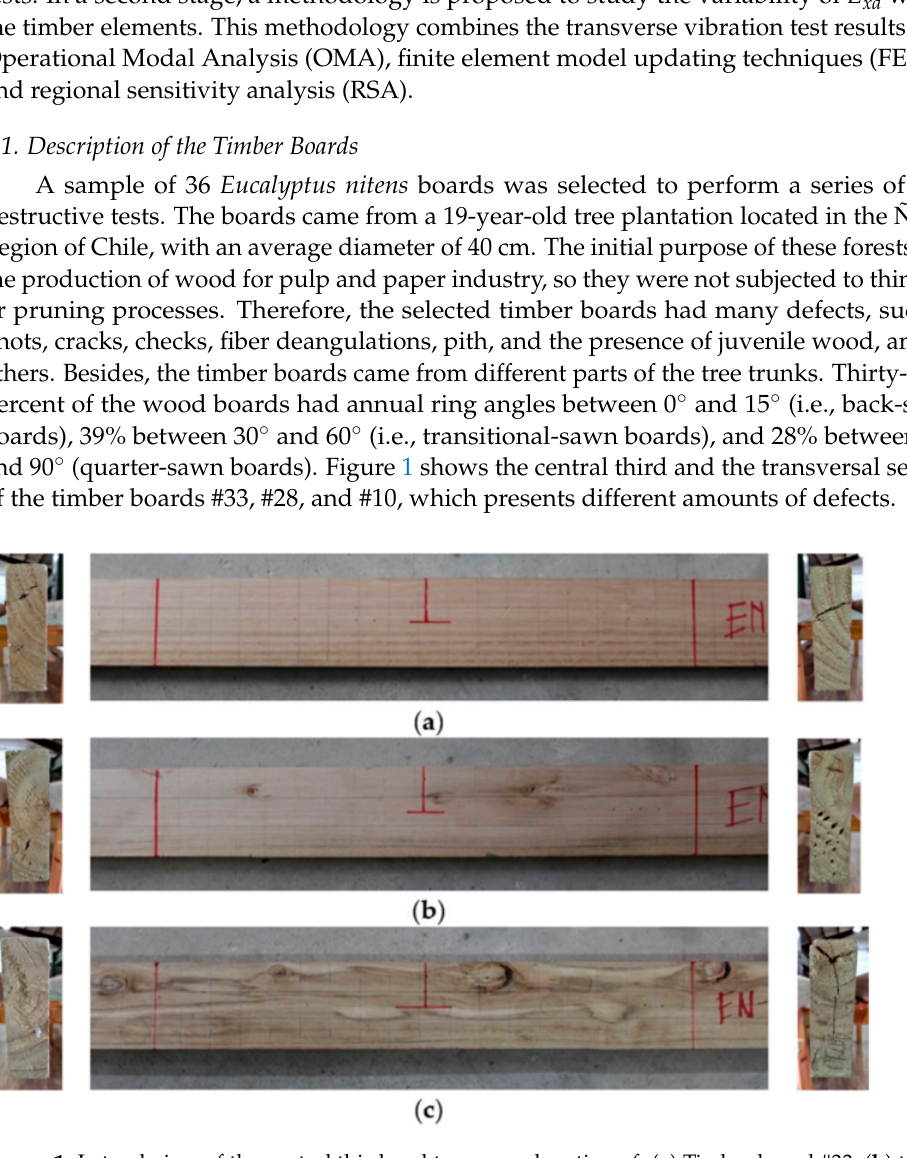
Figure 1. Lateral view of the central third and transversal section of: ( a ) Timber board #33, ( b ) timber board #28, and ( c ) timber board #